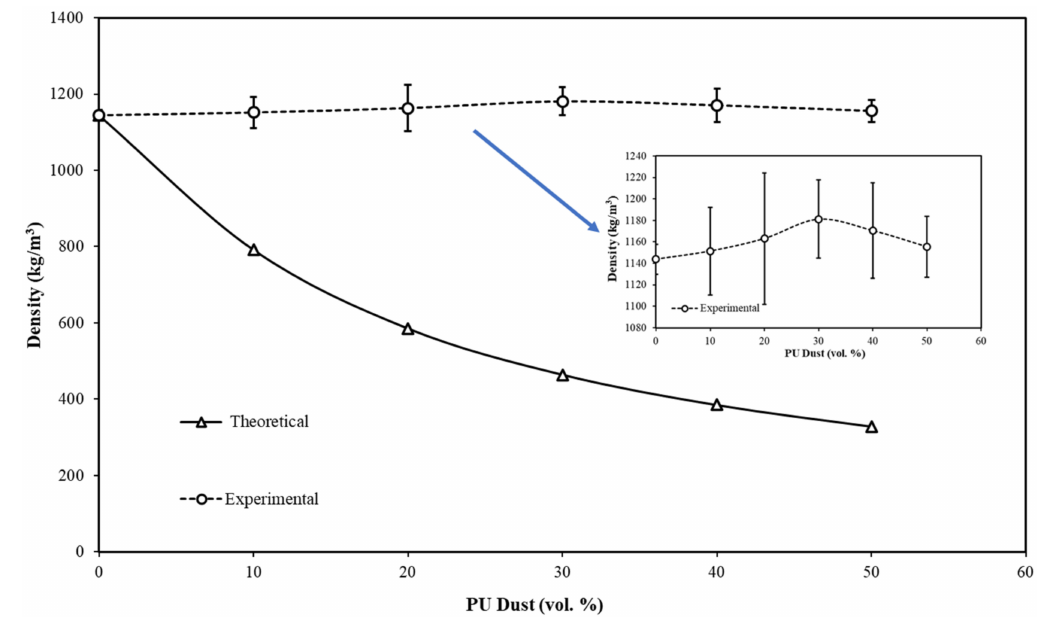
Figure 5. Experimental and theoretical density versus PU dust